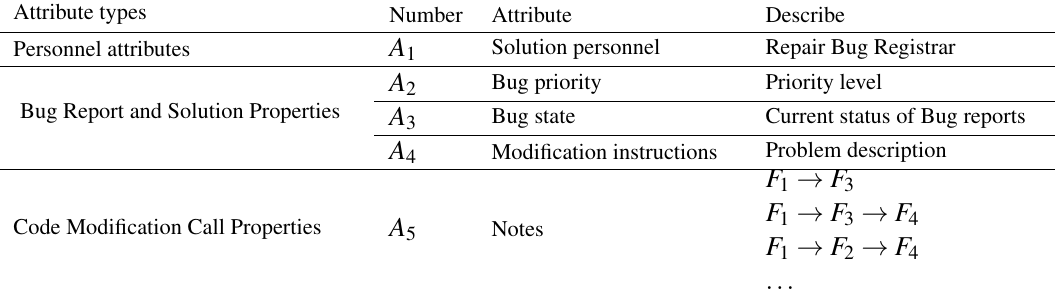
Table 1 Five Attributes and Interpretation of Bug Report Constructing Classifier